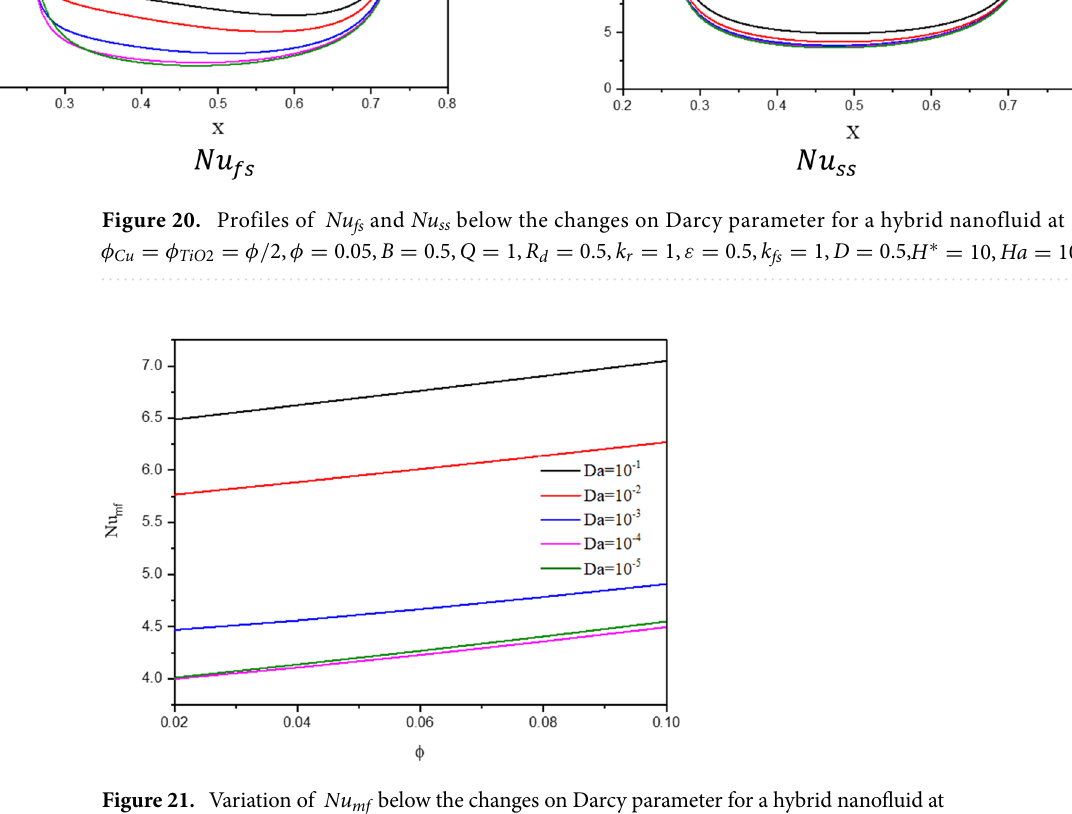
Figure 21. Variation of Nu mf below the changes on Darcy parameter for a hybrid nanofluid at φ Cu = φ TiO 2 = φ/ 2, B = 0.5, Q = 1, R d = 0.5, Da = 10 − 3 , ε = 0.5, k fs = 1, D = 0.5, H ∗ = 10, Ha =